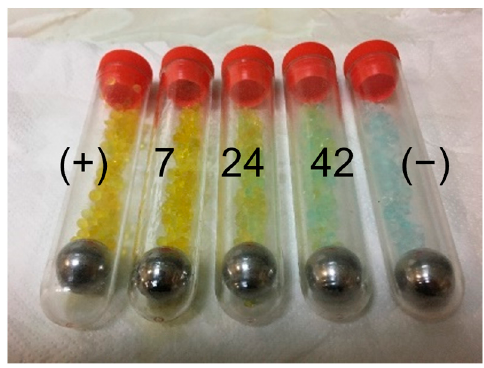
Figure 9. Desiccant control samples after 7, 24, and 42 days of ageing at 51 ° C. (+) stands for the positive reference with a desiccant at 0 days, and ( − ) stands for a negative reference with the desiccant in direct contact with the air for some minutes.